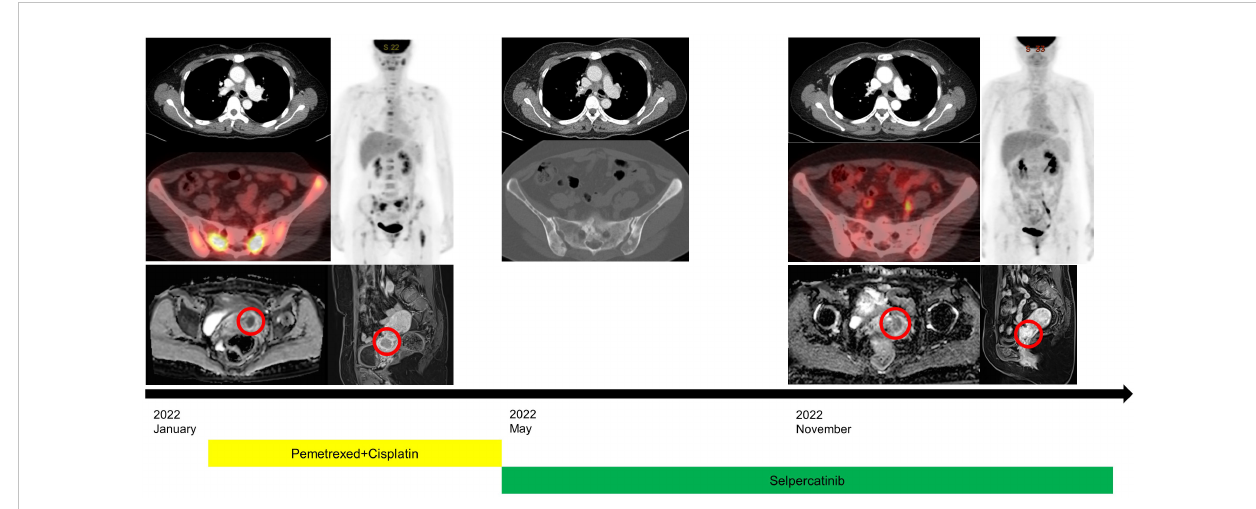
FIGURE 2 Clinical course with radiological images at initial diagnosis, the beginning of selpercatinib treatment, and after treatment. Positron emission tomography-computed tomography revealed a partial response for multiple bone metastases and slightly decreased size of uterine cervical metastasis (red circles) on pelvic magnetic resonance